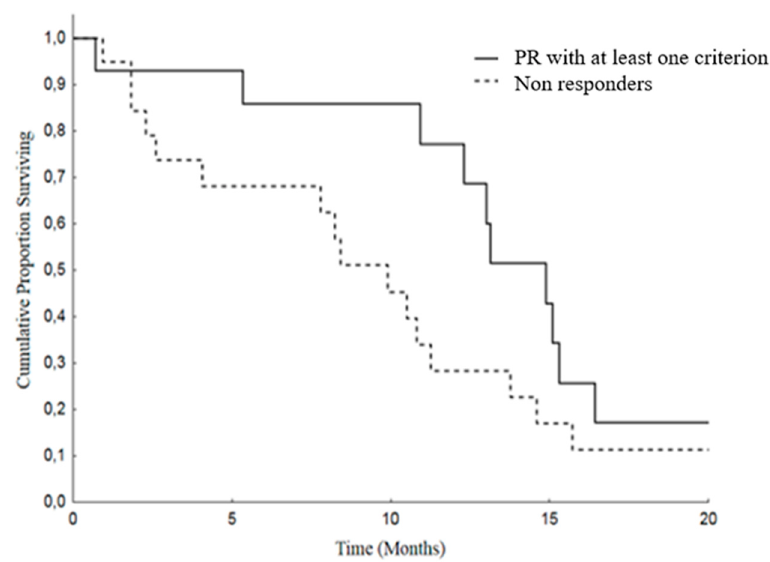
Figure 3. Progression Free Survival (PFS) in patients with PR with at least one criterion [median 14.9